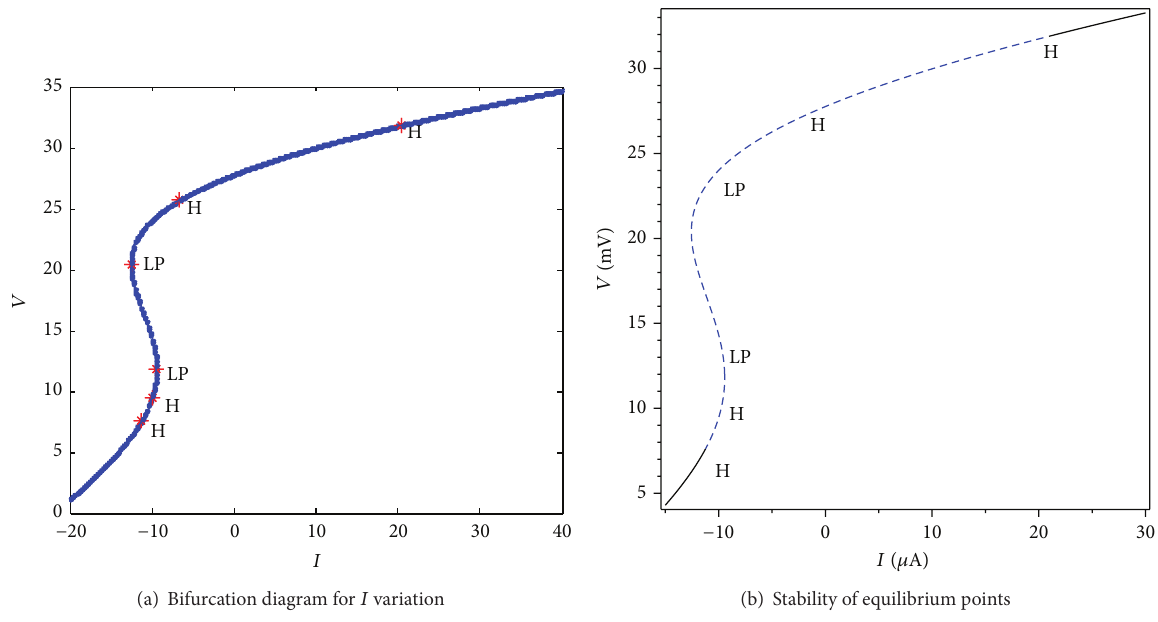
Figure 3: The bifurcation diagram and stability of equilibrium points for 𝑔 𝐿 = 2 , 𝑔